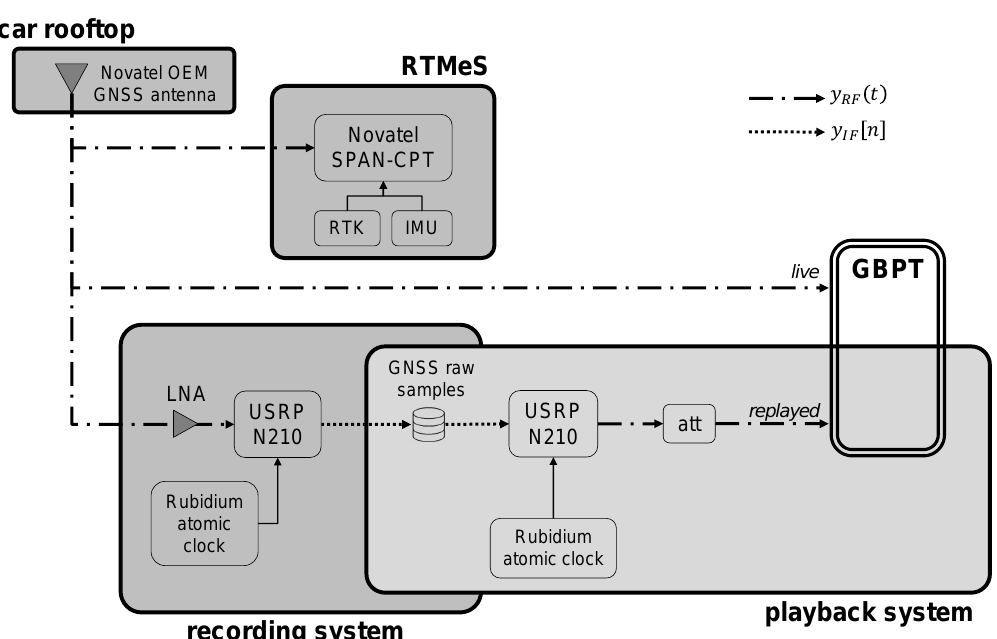
Figure 7. Record and replay system setup. RTMeS: Reference Trajectory Measurement System; RTK: real-time kinematic.